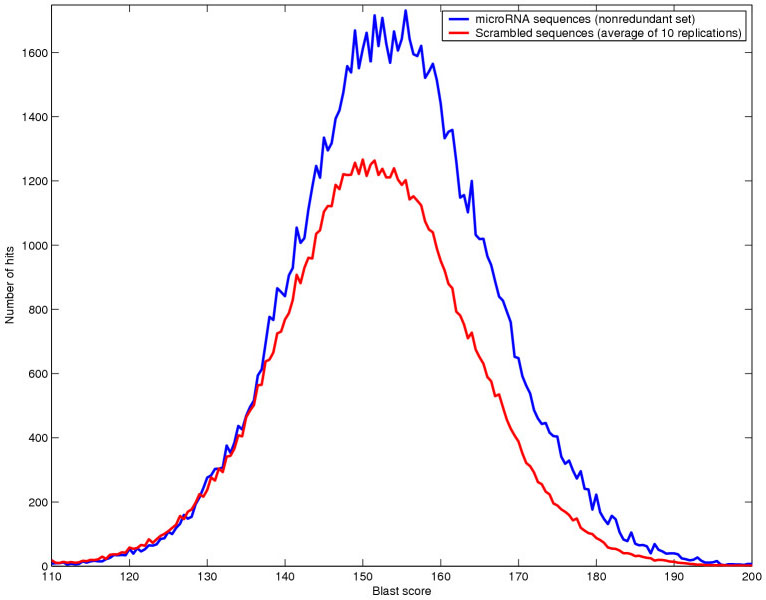
Distribution of gapped-BLAST scores in hits made by microRNAs and scrambled counterparts. Without permitting G:U matches in the extension phase, the microRNAs had better average gapped-BLAST scores than scrambled counterparts across all mRNAs in the "10+ set" (153.00 ± 0.03 vs. 150.98 ± 0.01, mean ± s.e.m., p < 0.0001). With permitting G:U matches in the extension phase, the microRNA set showed significantly fewer G:U matches overall relative to scrambled counterparts, even when holding constant the length of the exact hit (2.891 ± 0.004 vs. 2.939 ± 0.001, p < 0.0001).